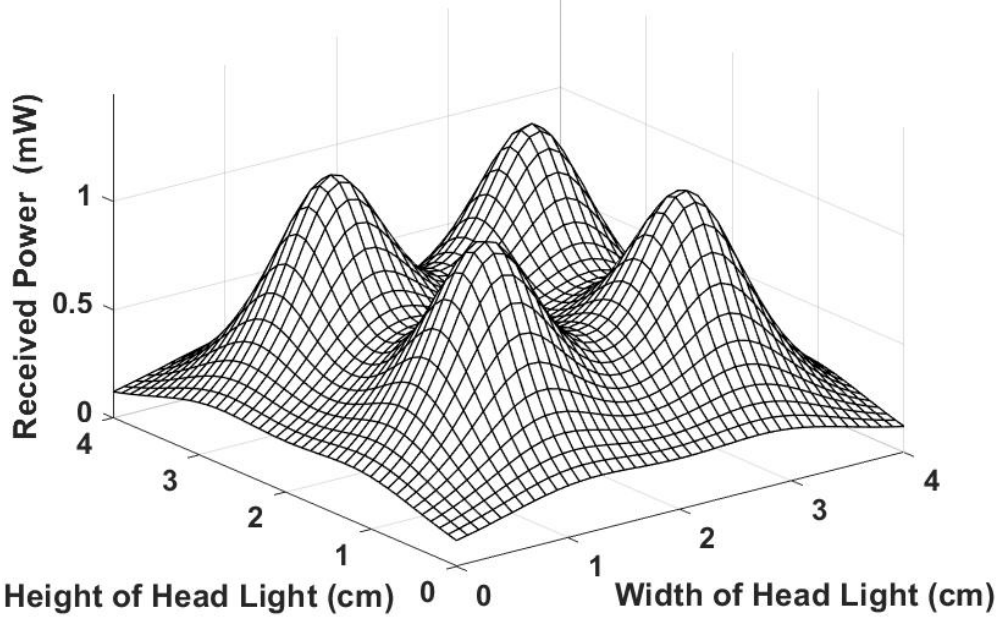
Figure 3. Received power (represented in the form of a 3D mesh) for the set of four LED units within the head light area of 4×4 cm 2.